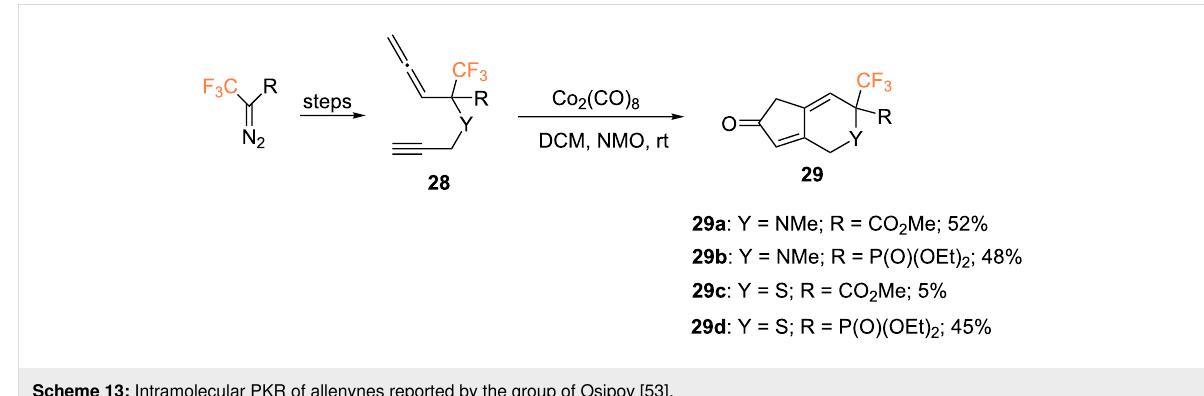
Scheme 13: Intramolecular PKR of allenynes reported by the group of Osipov [53].